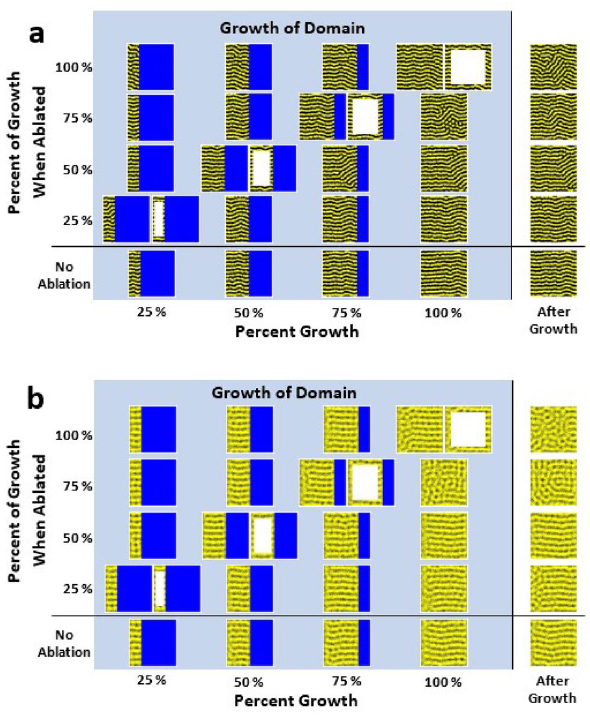
Figure 6. Ablation of Turing patterns at different percentages of growth. Simulations with the same conditions (one per row) were ablated at 25%, 50%, 75%, 100% of their total growth. The middle 75% of the domain was ablated (right side of each dual image—left side is simulation directly before ablation). Once the growth was complete, the simulations continued to run for ≈ 17% of the time of growth to observe the stability of the final pattern (far right of each simulation). ( a ) Growth simulations of the Promotion model with ablation. The domain grows from a 300 × 1 cell lattice to a 300 × 300 cell lattice. The conditions of each simulation (rows) are: h = 14, b X = 1, s = 1, l X = 2.5, b M = d M = d X = 0 . ( b ) Growth simulations of the Survival model with ablation. The domain grows from a 400 × 1 cell lattice to a 400 × 400 cell lattice. The conditions of each simulation (rows) are: h = 30, b X = 1, s = 1, b M = 7, d M = 9, d X = d MX = 0